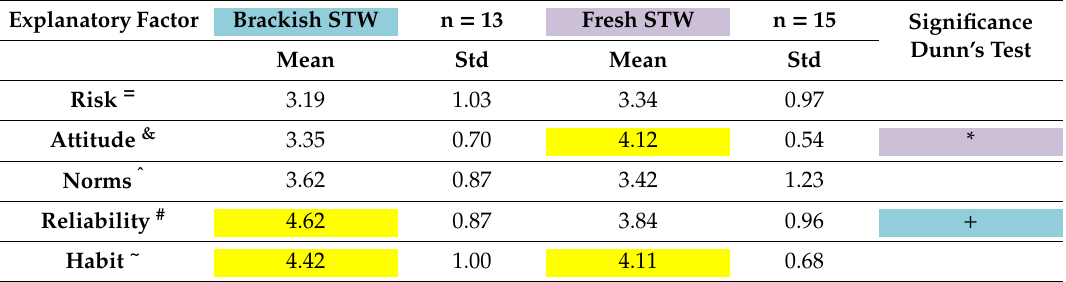
Table 4. Di ff erences in explanatory factors between brackish and fresh shallow tubewells. Barriers (values higher than 4) are highlighted in yellow. The colours and symbols in the last column indicate significant di ff erences and which group is higher: Brackish STW (teal + ) or fresh STW (purple *). As a reminder, the operationalisation of the factors is summarised below the table. Explanatory Factor Brackish STW n = 13 Fresh STW n =